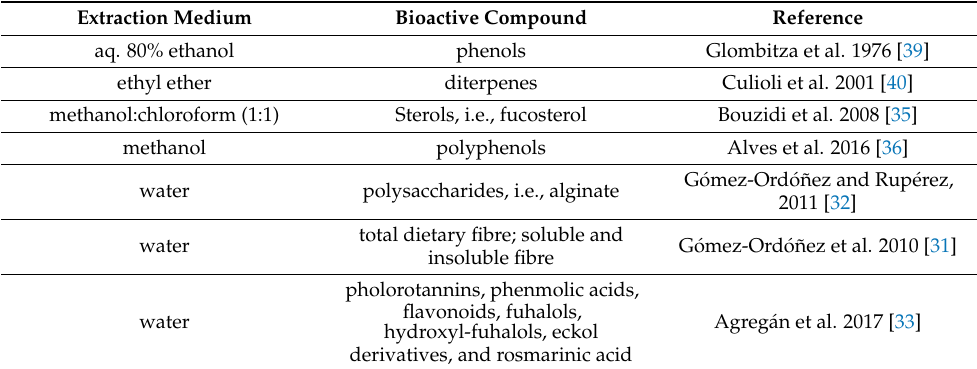
Table 2. Previous research related to analysis of bioactive compounds included in hydrophilic and lipophilic extracts of alga Bifurcaria bifurcata